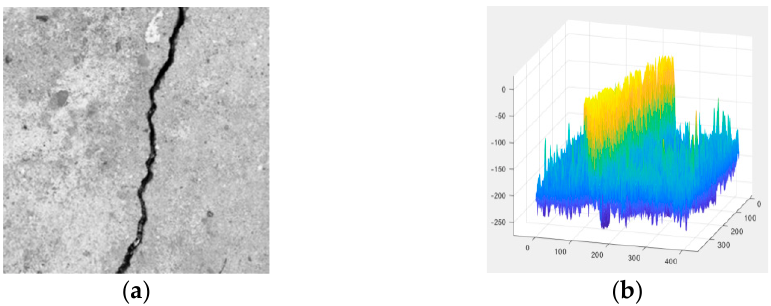
Figure 2. Gray value of fissure joint. ( a ) Rock fissure, ( b ) 3D graph of gray value. 1.